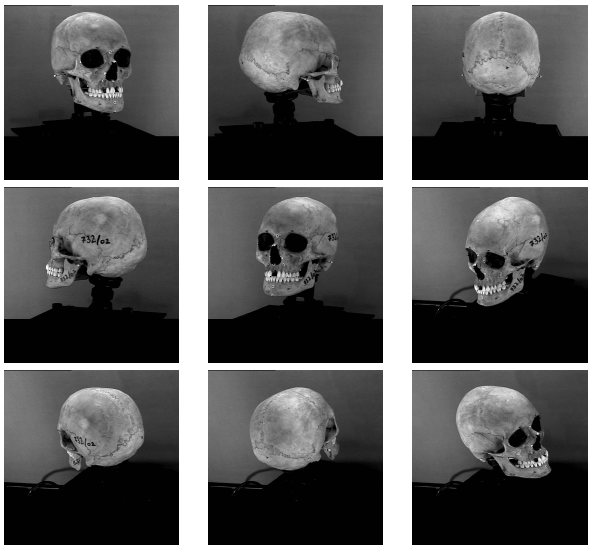
Figure 4. A set of texture images.